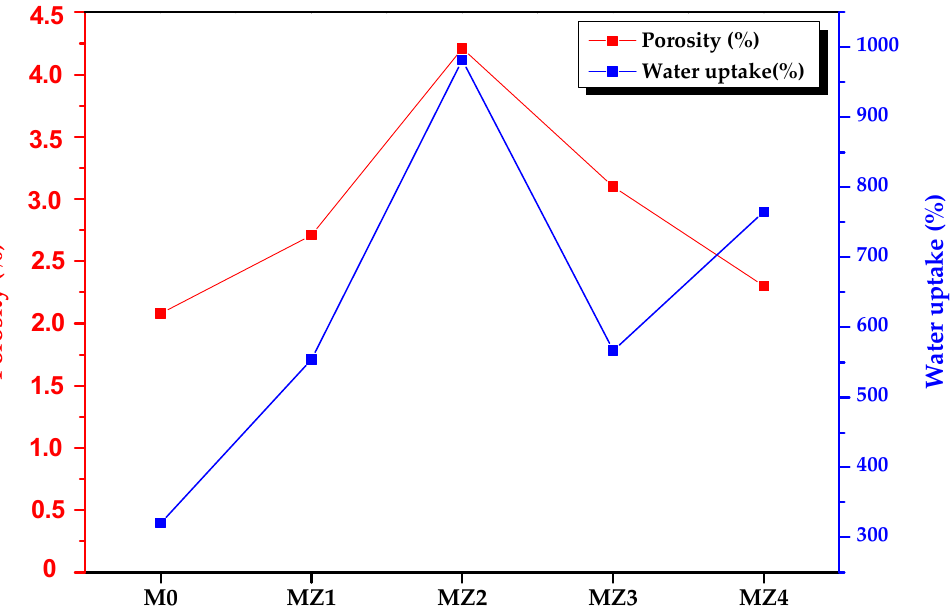
Figure 6. The measured water uptake capacity and calculated porosity of the prepared membranes.